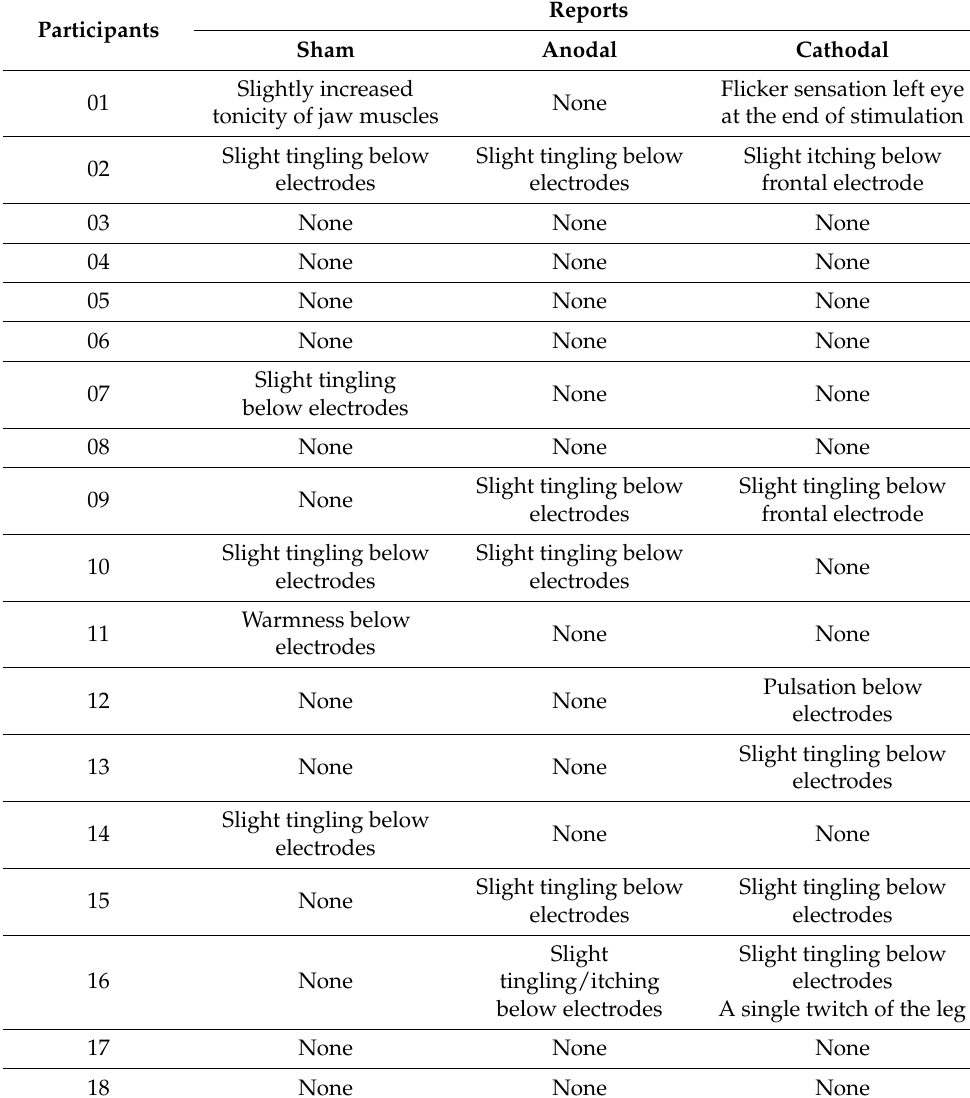
Table 1. Transcranial direct current stimulation (tDCS) side